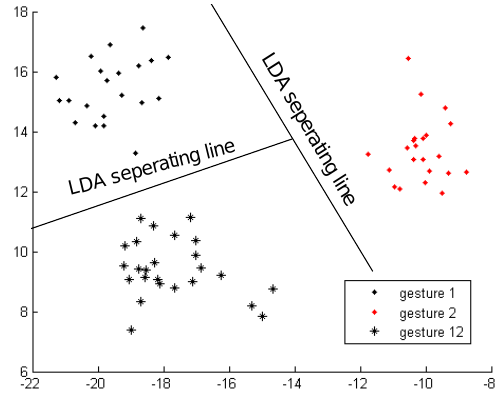
Figure 14. Classifier 5 in the third-level of the first subject.